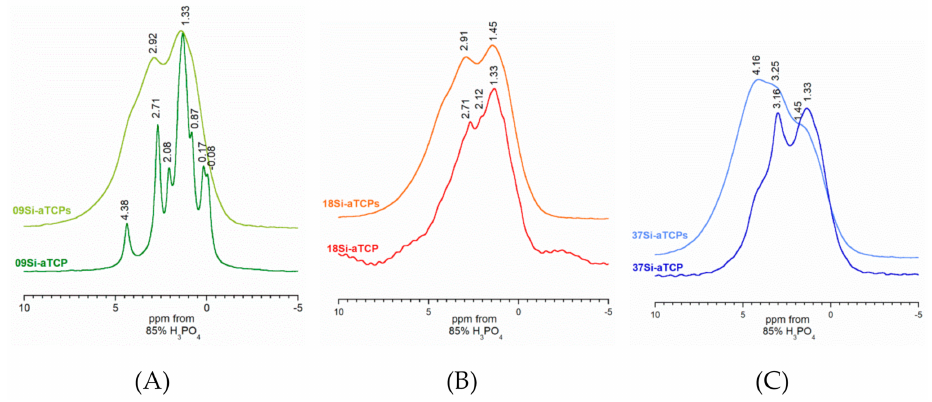
Figure 4. 31 P BD NMR spectra of the obtained powders: 09Si-aTCP and 09SiaTCPs ( A ), 18Si-aTCP and 18Si-aTCPs ( B ), 37Si-aTCP and 37Si-aTCPs ( C